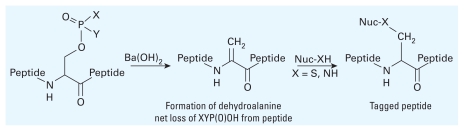
Ba(OH)2-induced dephosphorylation to tag proteins. Adapted from Noort et al. (2006). Nuc, nucleophile.